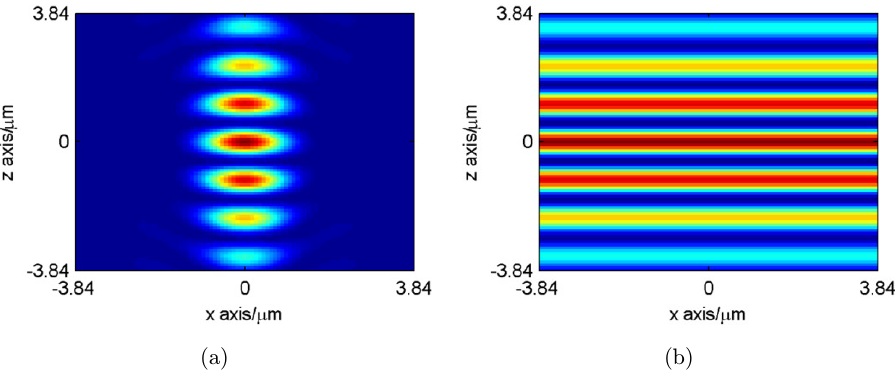
Fig. 6. The intensity distribution at the d / r value of 0.7. (a) shows the point spread function and (b) shows multiple light